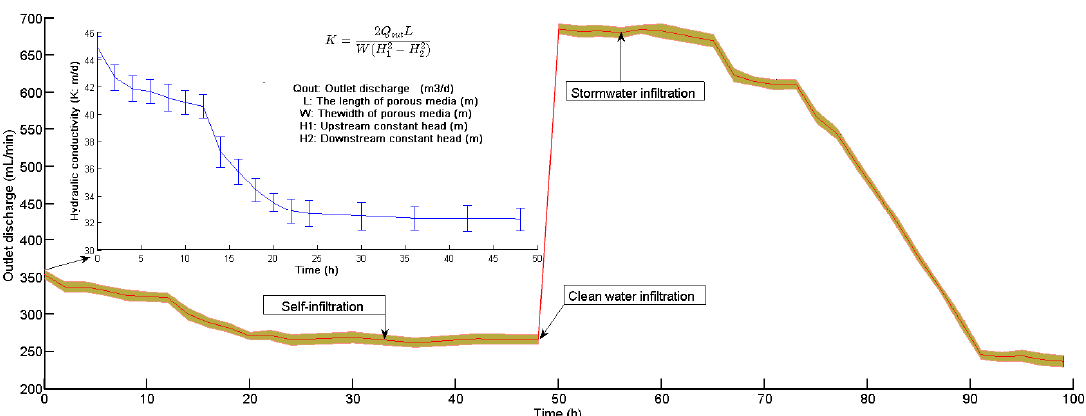
Figure 3. Evolution of outlet discharge rate during the whole experiment, including self-filtration stage (no water infiltration, and only the results of last two days are presented here); clean water infiltration stage; and stormwater infiltration (red and blue lines represent median values and orange area represents 95% confidence interval). Hydraulic conductivity ( K ) was calculated by the application of the Dupuit discharge formula.